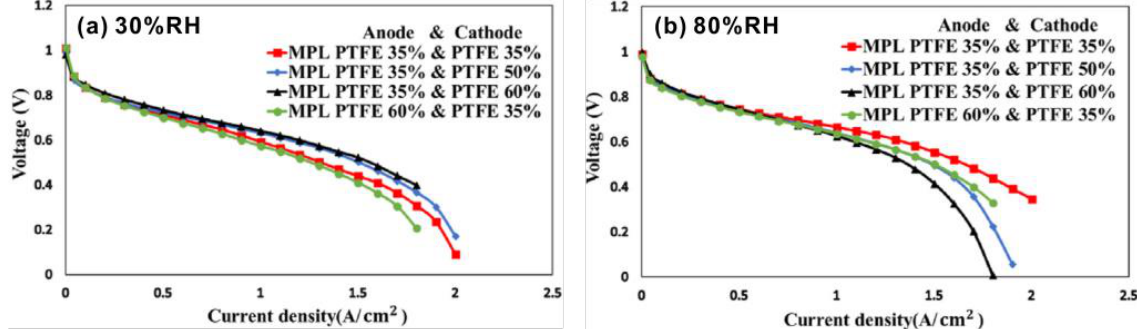
Figure 5. I – V curves of the PEMFCs with different PTFE content in the GDLs in anodes and cathodes at specific relative humidity of ( a ) 30%, and ( b ) 80%. Reproduced with permission [73]. Copyright 2021, Elsevier.